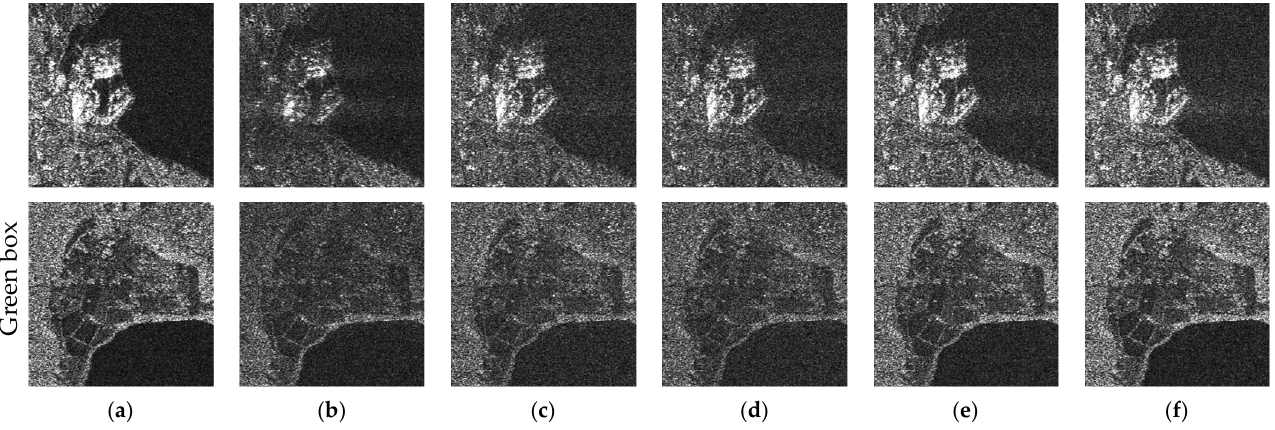
Figure 15. Comparison of the enlarged areas in Figure 14: (Row 1) the red box region; (Row 2) the green box region. ( a ) The RFI-free SAR image, ( b ) ISNF, ( c ) ESP, ( d ) GoDec, ( e ) LRDS, and ( f ) TFC- LRS.